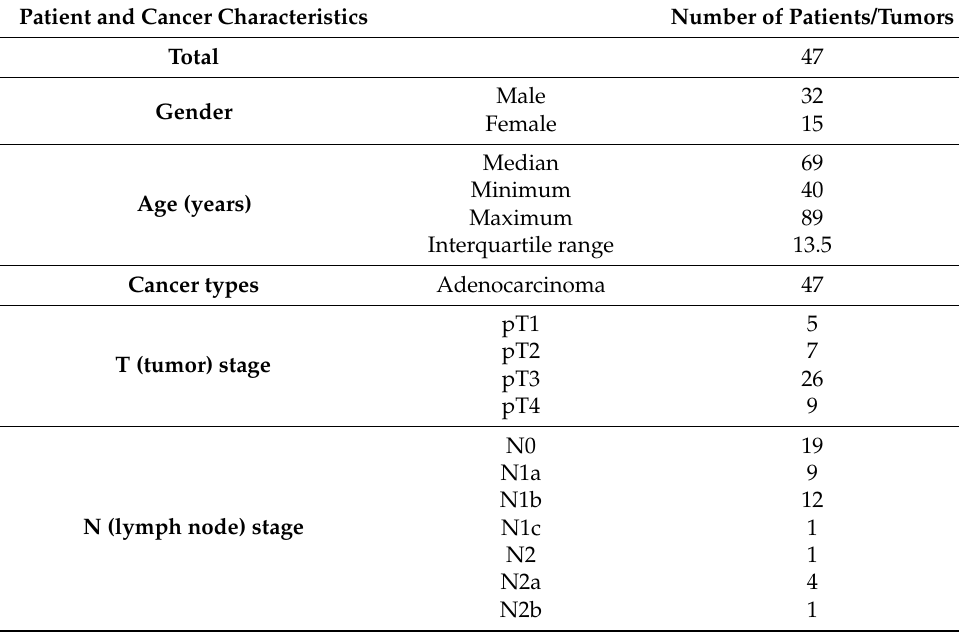
Table 1. Patient demographics, cancer types and tumor staging